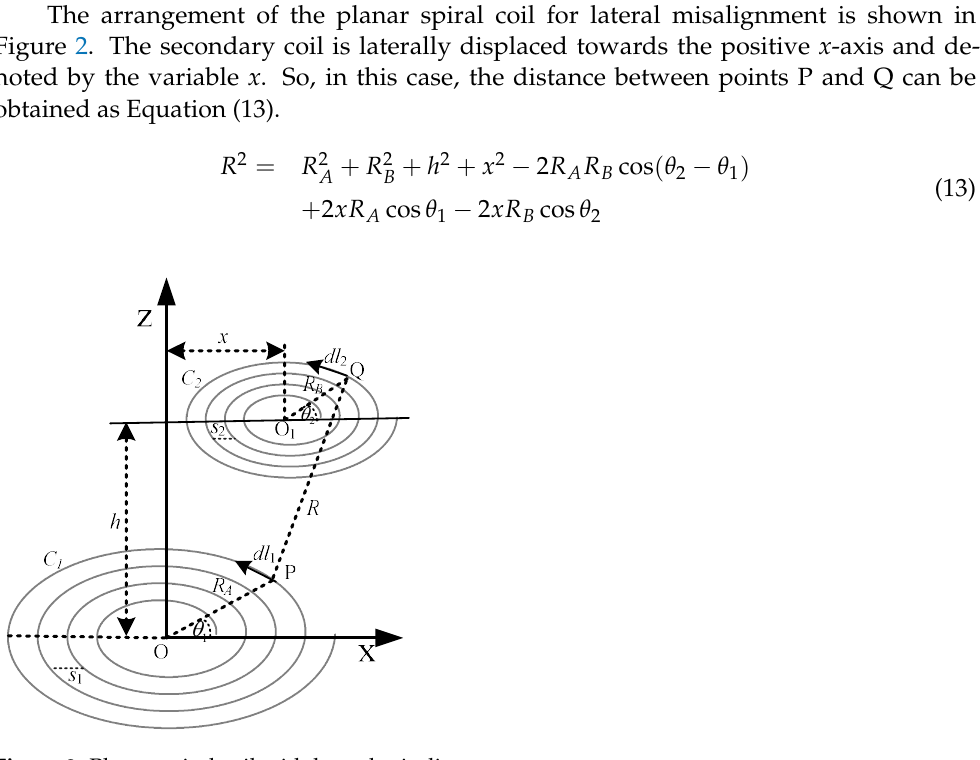
Figure 2. Planar spiral coil with lateral misalignment.